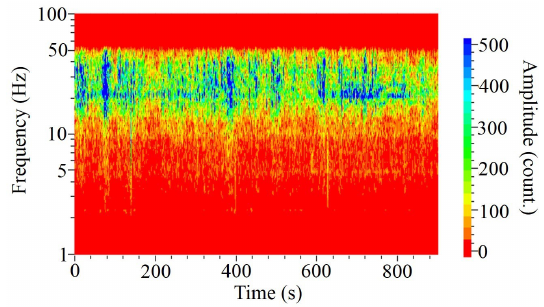
Figure 7. Spectrogram of the signal recorded by station V1 (loca- tion is shown in Fig. 2) and used as a wavefield of the source in the simulation.